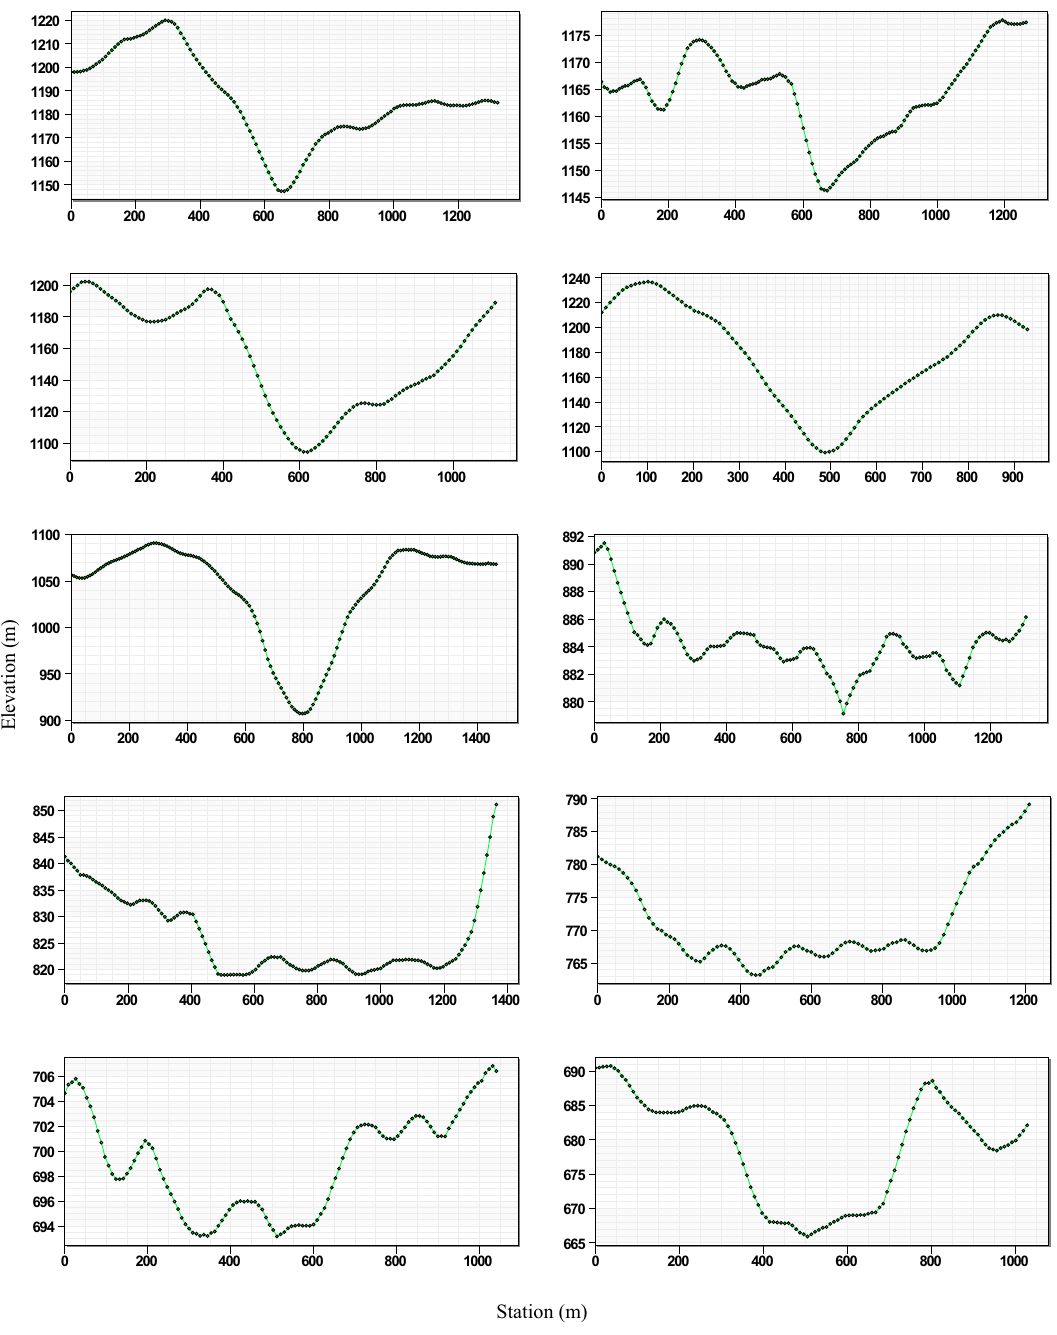
Fig. 4 Sample cross-sections used in modeling of streams of hydrographic network of the Karvandar River used in 1-D hydraulic